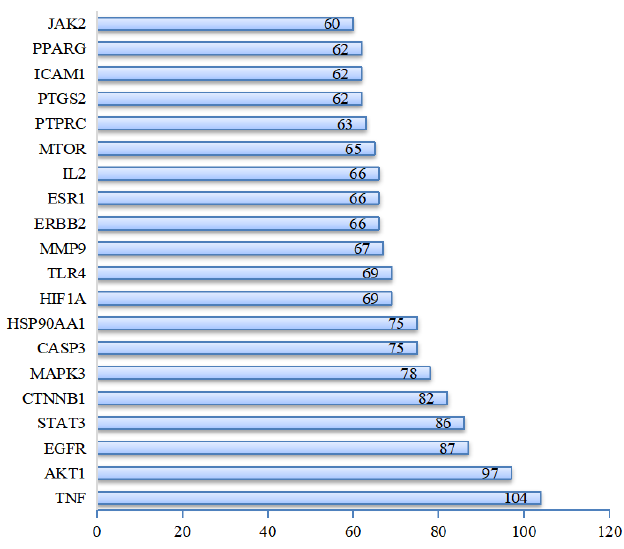
Figure 5. Top 20 Key Targets in PPI Network.